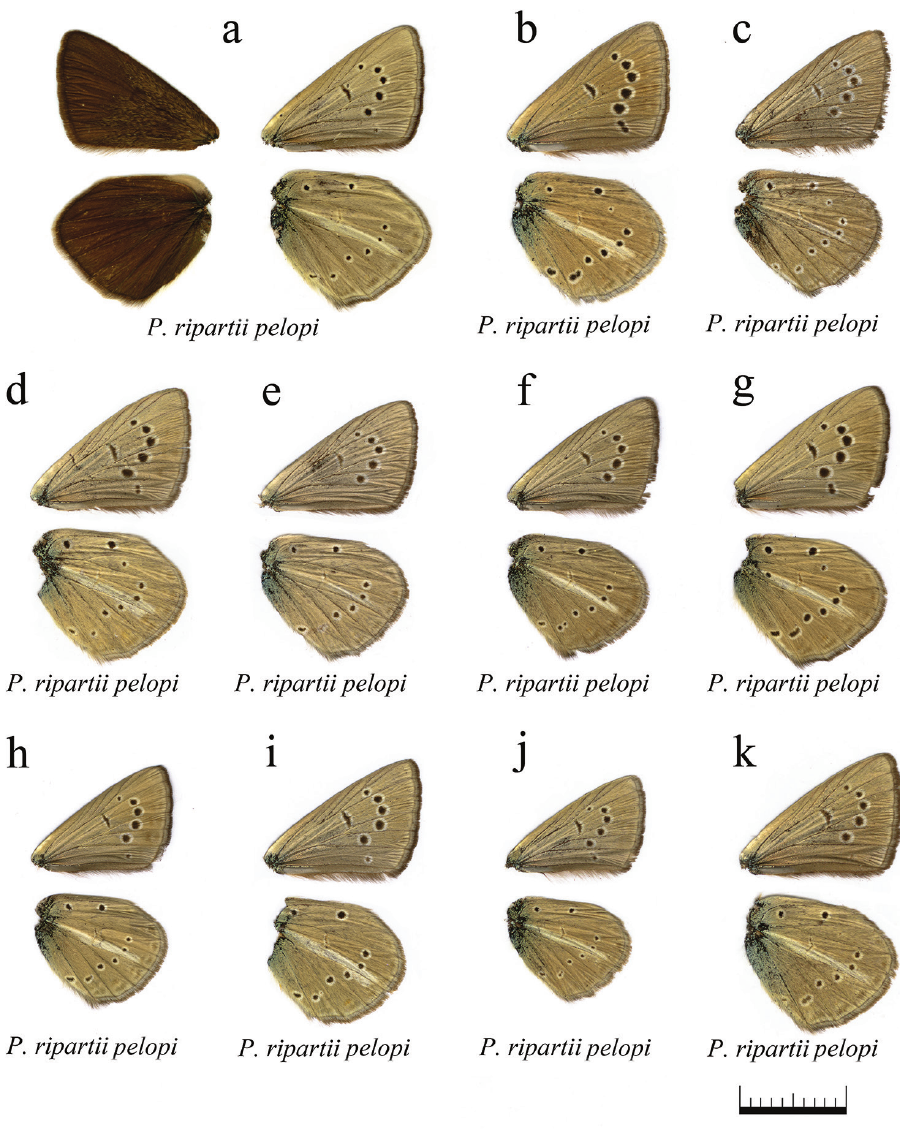
Figure 15. The coloration and wing pattern of P. ripartii pelopi . The letters correspond to the following sample numbers: a LR-08-D257 upperside and underside b LR-08-471 c LR-08-085 d LR-08-092 e